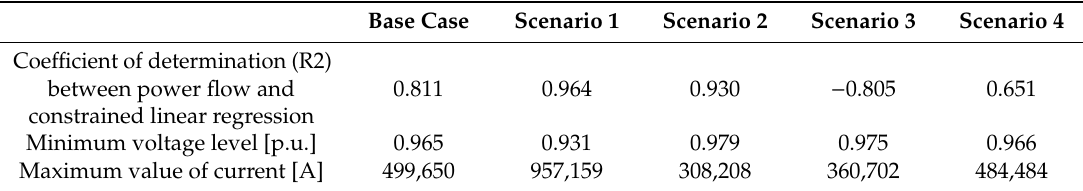
Table 3. Simulation